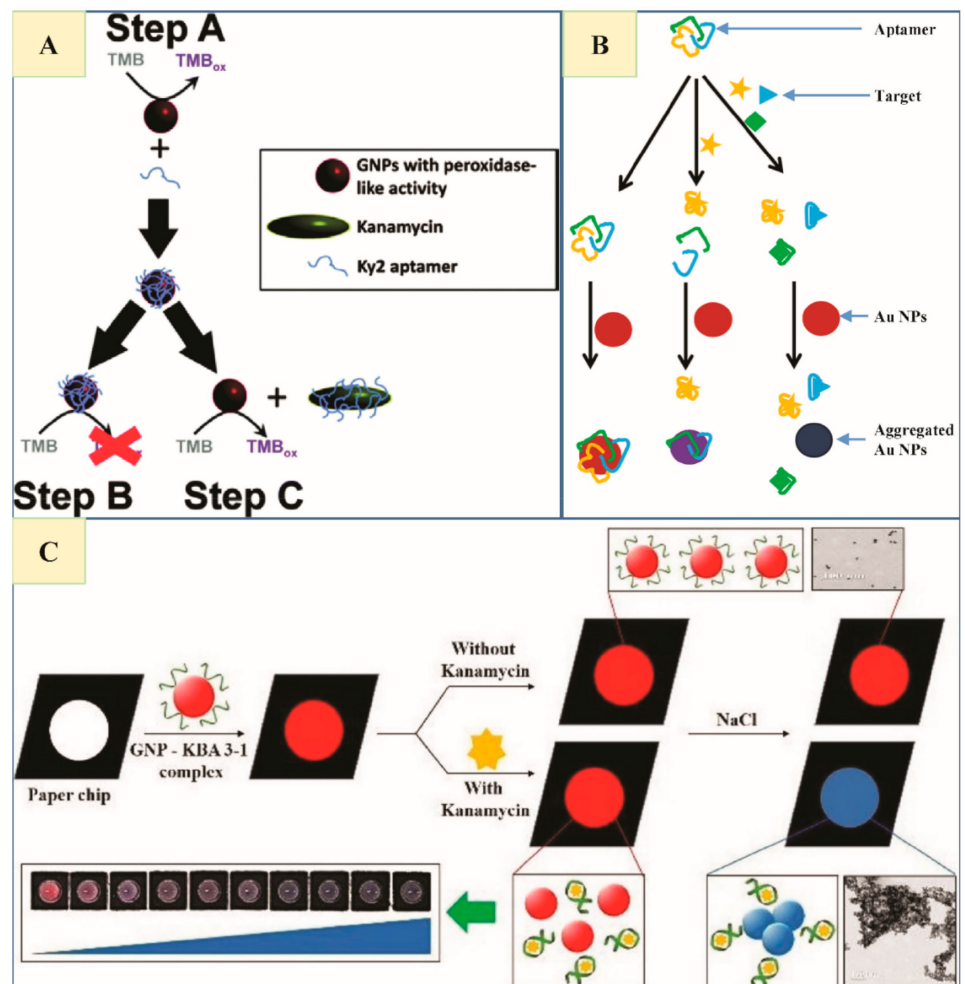
Figure 2. ( A ) Schematic depiction of the ‘turn-on/turn-off’ nanozyme catalytic activity of aptamer-functionalized AuNPs for Kanamycin (KAN) detection (Step A) showing intrinsic peroxidase activity of AuNPs when they ‘turn-off’ after functionalization with Ky2 in the absence of KAN (Step B), and ‘turn-on’ again in the presence of KAN (Step C) (Reproduced with permission from [61] © 2014 Royal Society of Chemistry). ( B ) A schematic illustration of multiplex antibiotic detection using a colorimetric aptasensor based on a simple working principle (Reproduced with permission from [63] © 2014 Plos ne). ( C ) A schematic demonstration of a paper chip-based AuNPs colorimetric aptasensor for KAN detection (Reproduced with permission from [64] © 2017